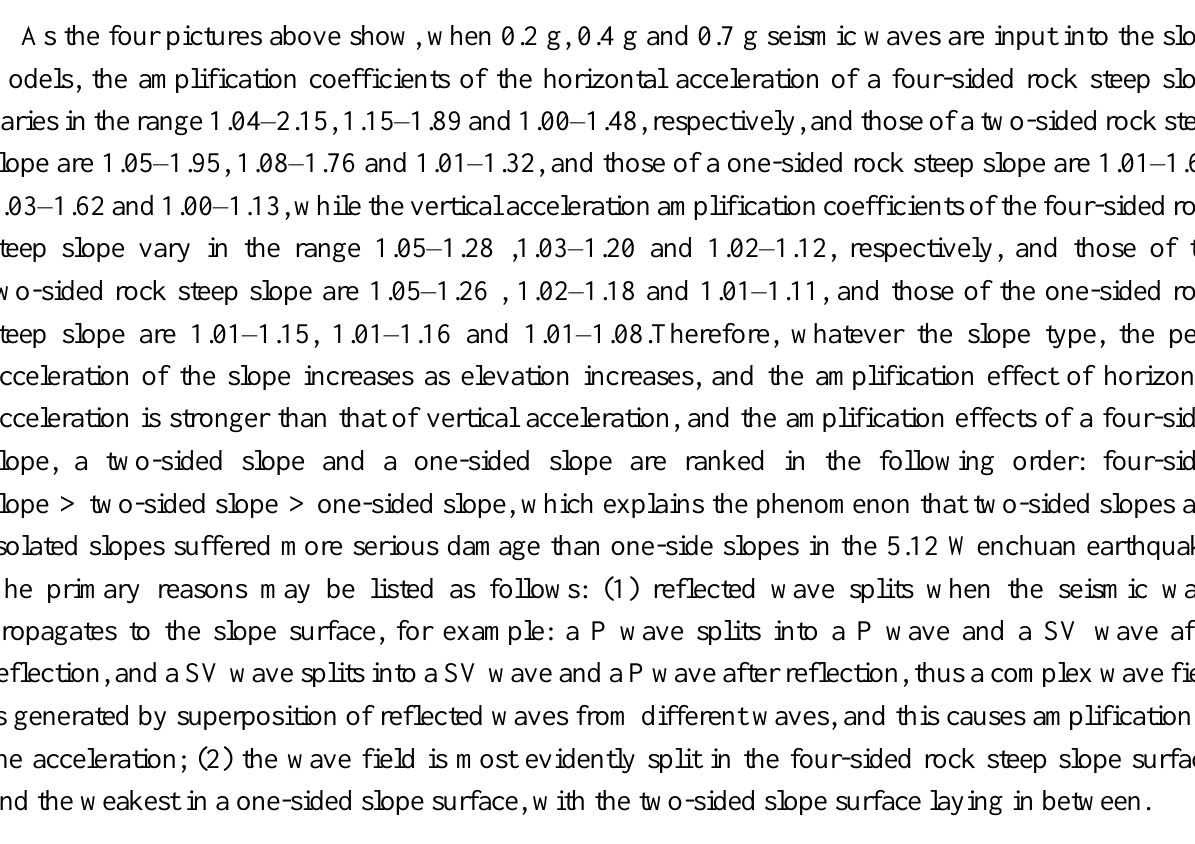
Figure 14. Horizontal and vertical acceleration amplifications when the input is PGA = 0.7